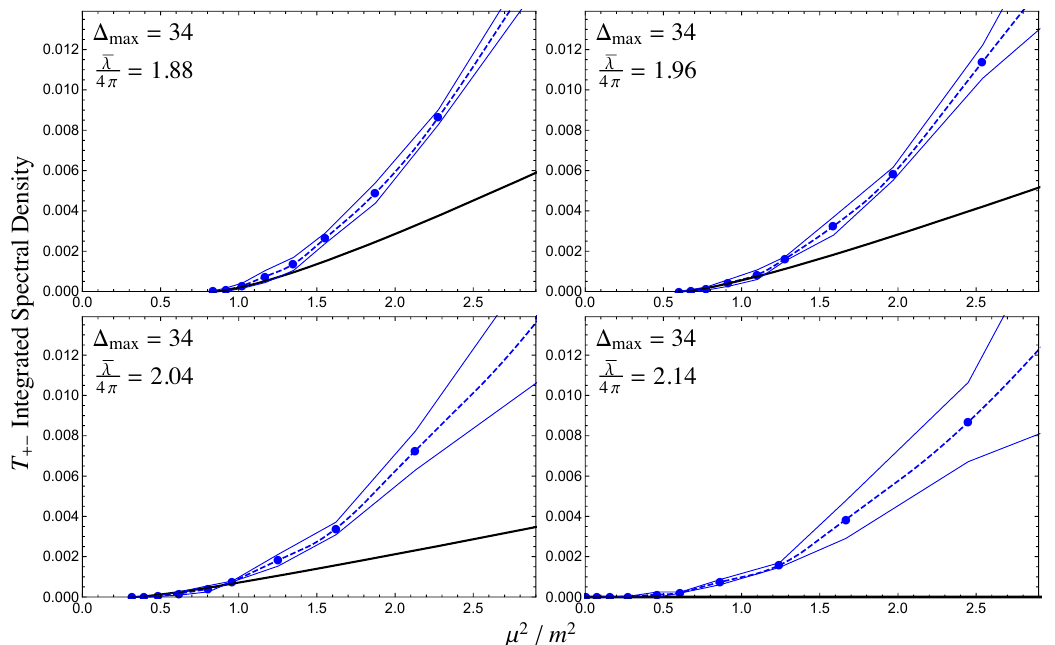
Figure 7 . Integrated spectral densities for T + (cid:0) , for (cid:1) max = 34 and di(cid:11)erent values of (cid:22) (cid:21) , compared to the Ising model prediction (black curve). The thin blue lines indicate the magnitude of the di(cid:11)er- ence between these results and those at (cid:1) max = 30, providing a rough estimate of the convergence. For reference, the upper right plot corresponds to the same value of the coupling ( (cid:22) (cid:21) (cid:12)gure